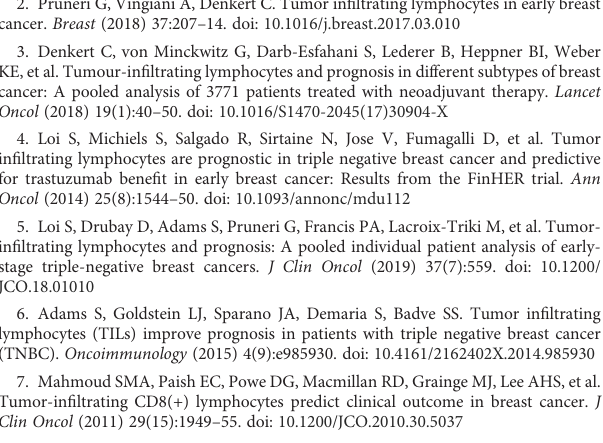
SUPPLEMENTARY FIGURE 11 The predictive value of the LNPRS for chemotherapy ef fi cacy in the TCGA cohort. (A – Y) Differences in sensitivity to various chemotherapy drugs in the low and high-risk